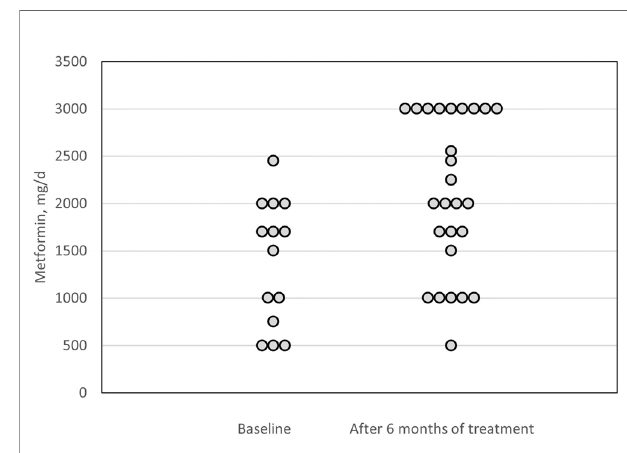
FIGURE 4 | Metformin doses at baseline and after 6 months